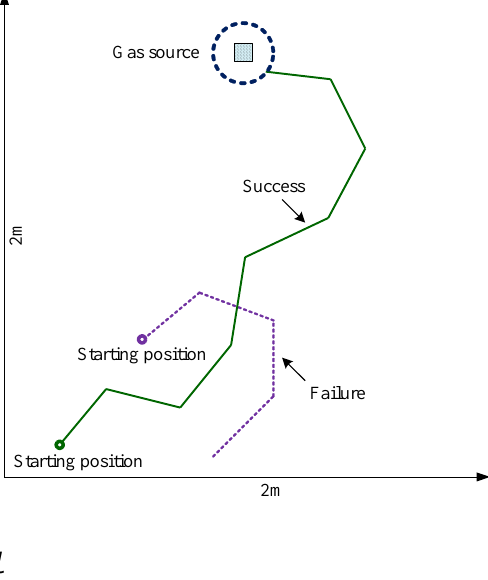
Figure 12. Odor source search path of olfaction